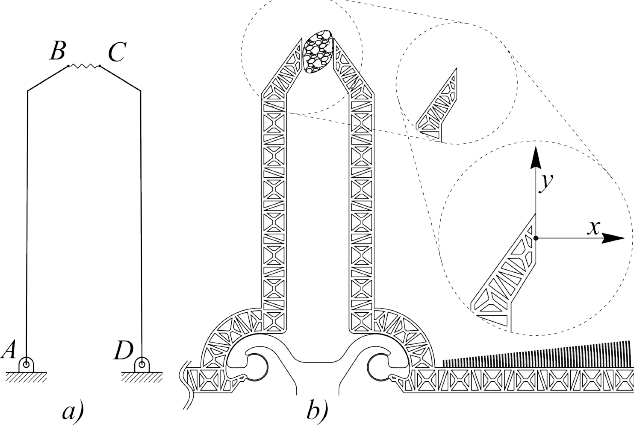
Figure 1. Pseudo-rigid body model ( a ) and original structure ( b ) of the microgripper with two degrees of